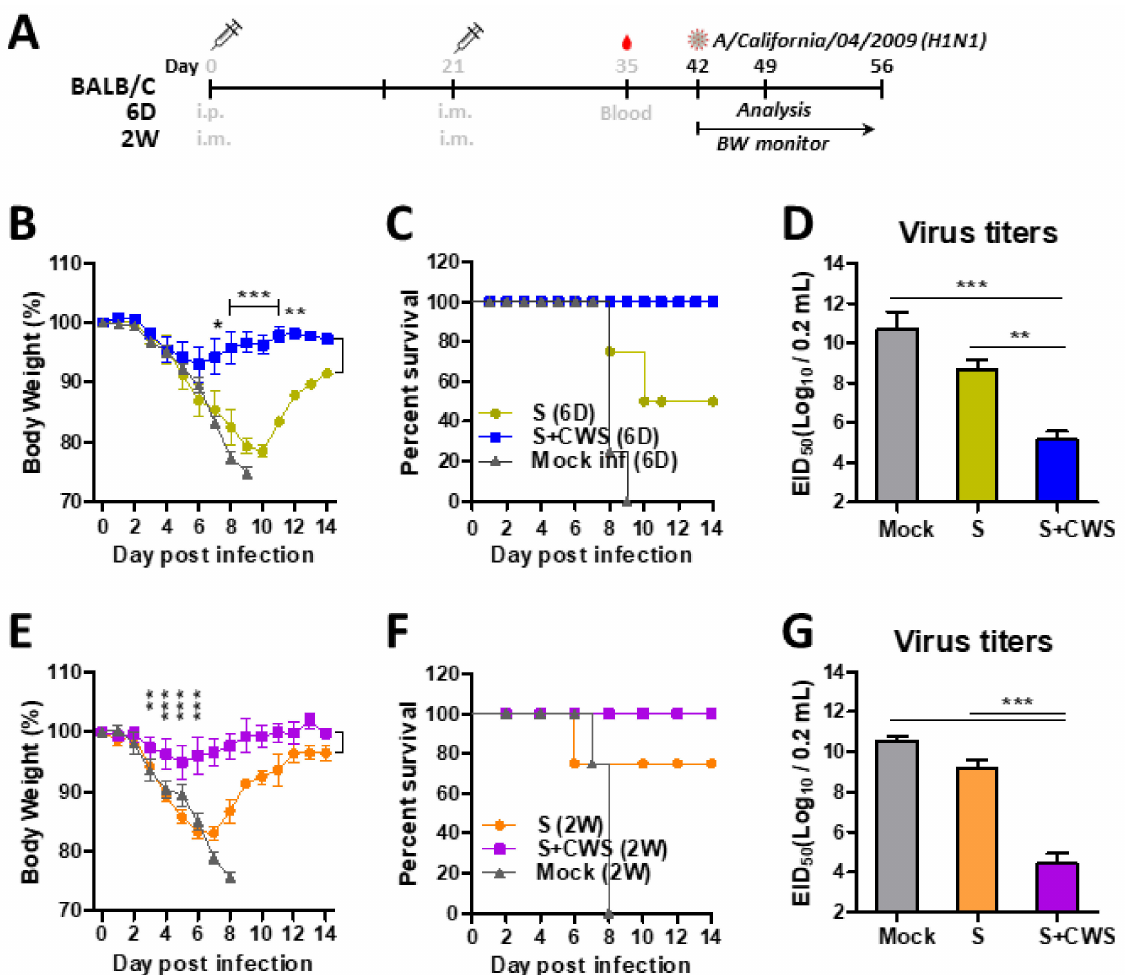
Figure 3. BCG-CWS adjuvant effects on enhancing protective efficacy in vaccinated 6 D and 2 W age mice. ( A ) Challenge plan of immunized mice. Vaccinated 6 D and 2 W groups were challenged with A/Cal virus (2 × LD 50 ) at 3 weeks after boost. ( B , C ) Body weight changes and survival rates in 6 D age mice ( n = 8). ( E , F ) Body weight changes and survival rates in 2 W age mice ( n = 8). ( D , G ) Lung viral titers were determined by an egg inoculation assay at 7 dpi ( n = 10). Statistical significance was calculated by using one- or two-way ANOVA and a Bonferroni’s multiple-comparison test. Error bars indicate the mean ± SEM. *; p < 0.05, **; p < 0.01, ***; p <